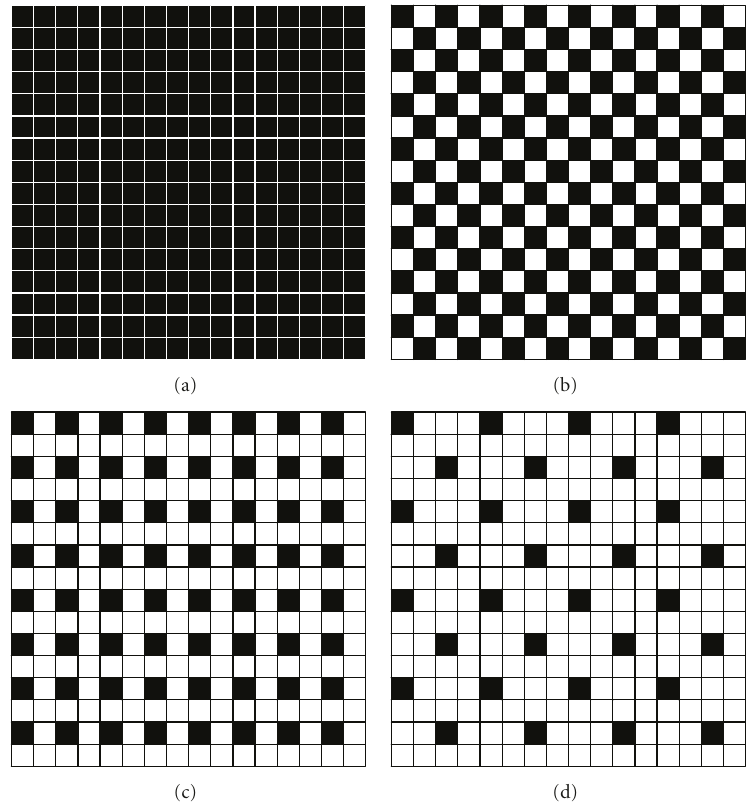
Figure 2: (a) 16 :16 subsample pattern, (b) 16:8 subsample pattern, (c) 16 :4 subsample pattern and (d) 16:2 subsample